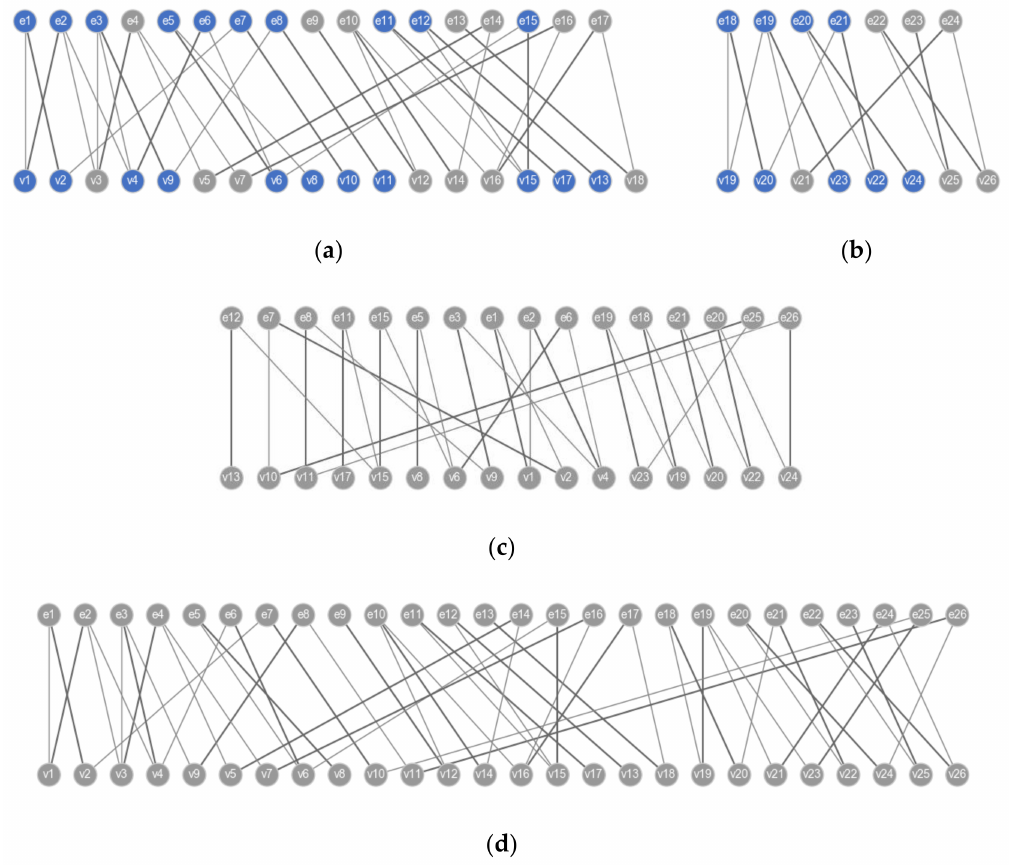
Figure 7. Hierarchical structural analysis of the NLAE model in Figure 6. ( a ) Decomposition of the circuit model. ( b ) Decomposition of the shell model. ( c ) Structural analysis result of the dummy model. ( d ) Structural analysis result of the flattened